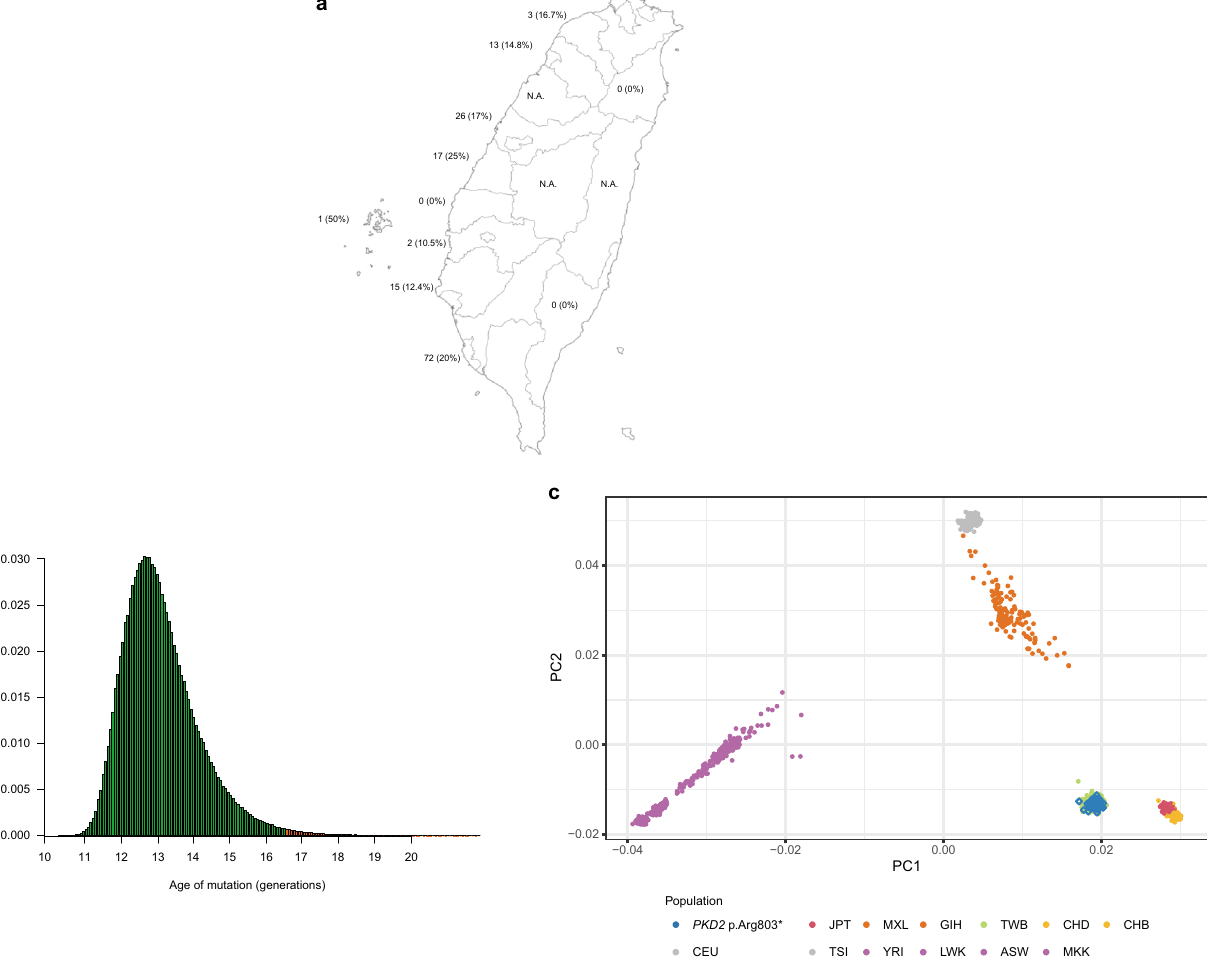
Fig. 3 Geographic location, percentage, age of mutation, and principle component analysis of PKD2 p.Arg803*. a Geographically, PKD2 p.Arg803* was found all over Taiwan and represented 10 – 25% of the ADPKD collected from different area. Extreme PKD2 p.Arg803* percentages (0 and 50%) were most likely due to small sampling sizes. The number represented PKD2 p.Arg803* family identi fi ed in that county along with its percentage (in brackets). b The histogram produced by the DMLE + 2.3 showed the posterior probability plot of the estimated mutation age of the 250 kb region of PKD2 p.Arg803*. With average population growth rate of 1.31%, the estimated peak age appeared 12.6 generations ago (95% CI: 9.4 – 16.0). Assuming 25 years as an average generation, the PKD2 p.Arg803* mutation was introduced 300 years ago (95% CI: 235 – 398, indicated by the gray bar) in Taiwan. c The principal component analysis of genetic structure across 96 PKD2 p.R803* carriers, 480 control individuals from Taiwan Biobank, and HapMap Project. ASW African ancestry in Southwest USA, CEU